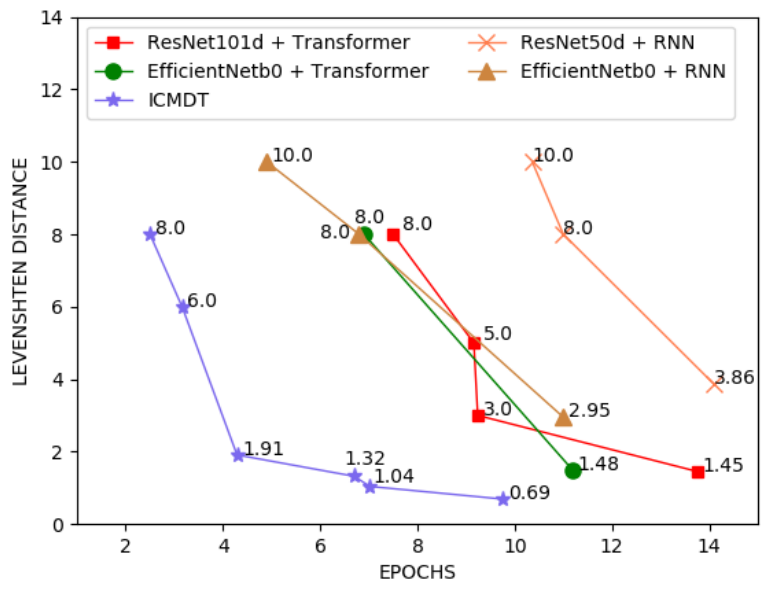
Figure 9. Convergence process